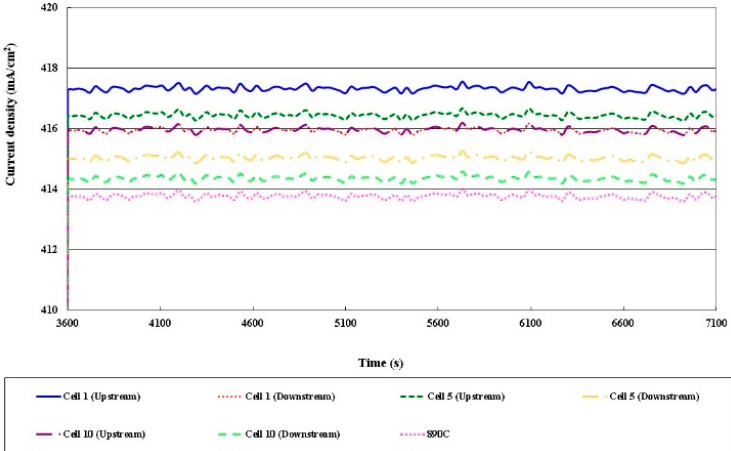
Figure 15. Comparison of local current densities in different cells (part of 13 A).